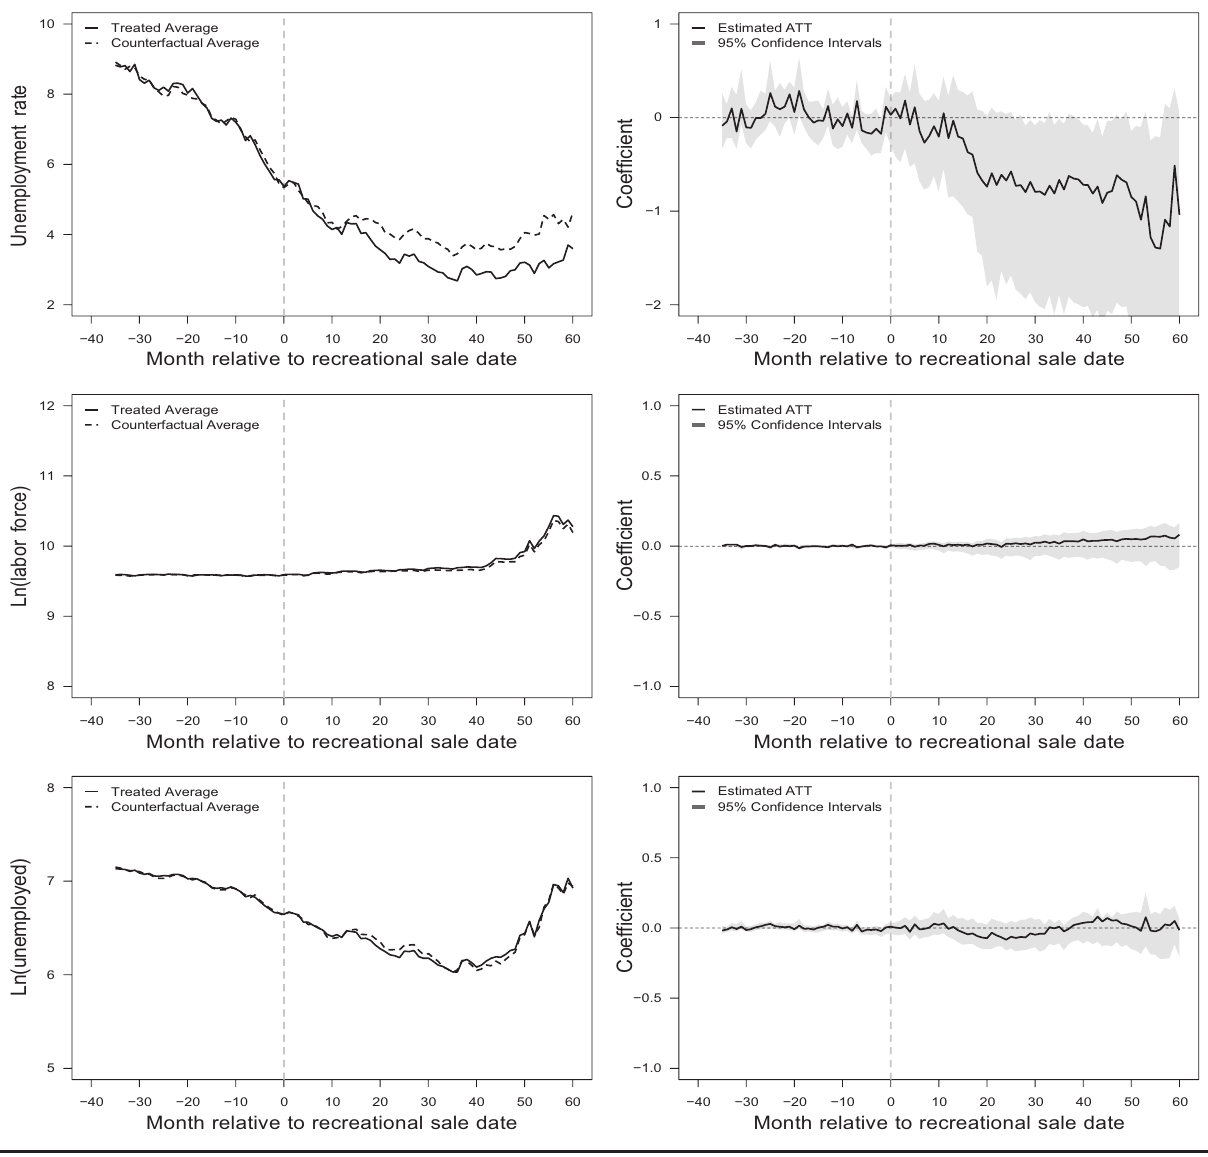
Figure 5 The effect of recreational dispensary entry on the unemployment rate, Ln(labor force), and Ln(unemployed) –